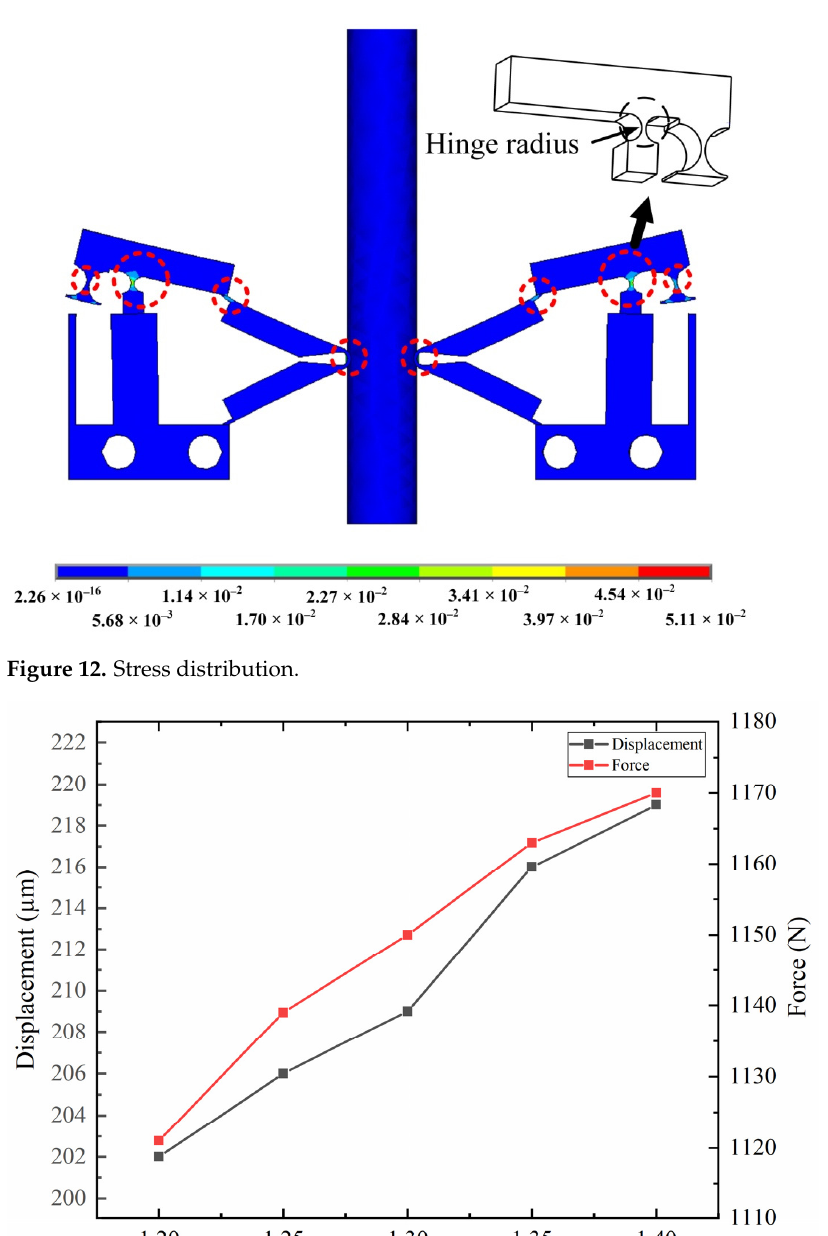
Figure 13. Parametric analysis of hinge radius.